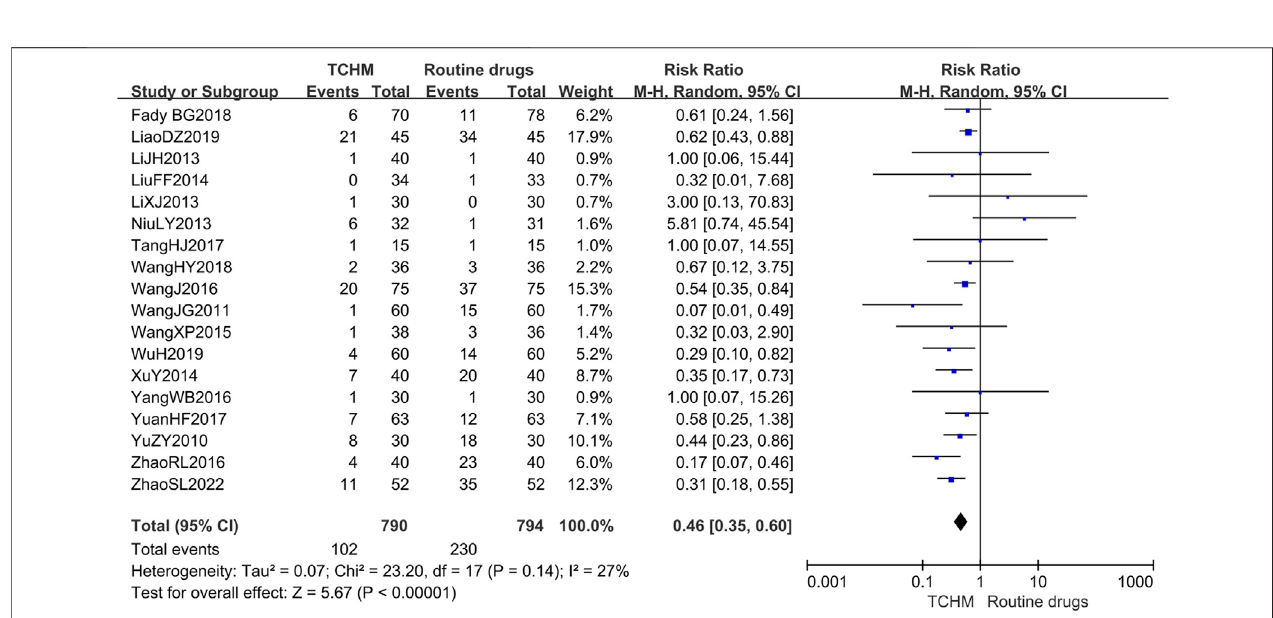
FIGURE 6 | Forest plot and pooled risk ratios for association of RTOG grading criteria with TCHM and routine drugs.